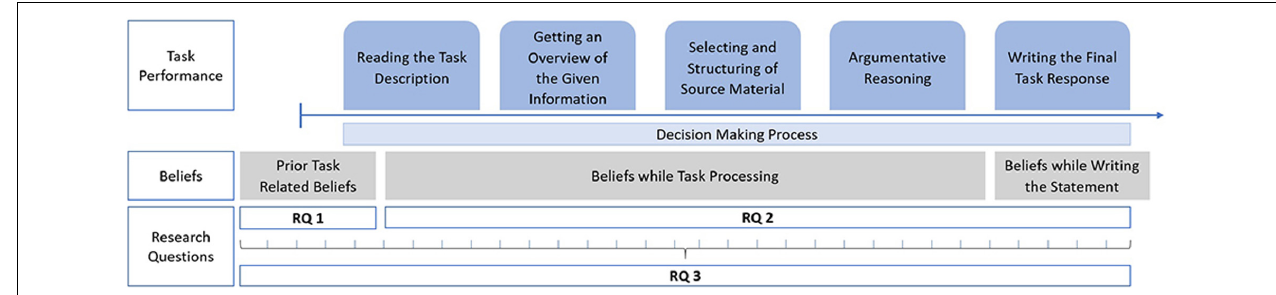
FIGURE 1 | The analytical framework of the study including the research questions ( RQ